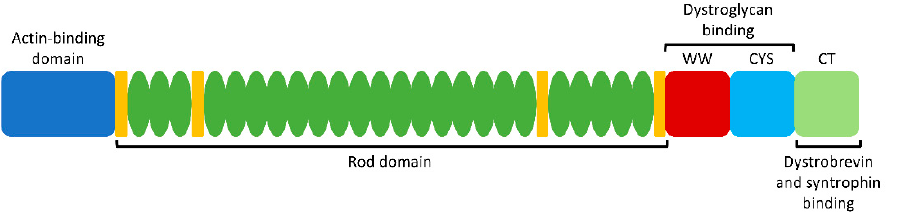
Figure 1. Dystrophin protein structure. Key functional domains, from left to right: N-terminal actin-binding domain, central rod domain with 24 repeats and 4 hinge regions, WW and cysteine-rich (CYS) domains (dystroglycan binding site), and carboxy-terminal (CT) domain (dystrobrevin and syntrophin binding sites). Since the rod domain is partially redundant, skipping or removing part of this region is typically well tolerated. Conversely, the N and C termini are essential for proper dystrophin function.